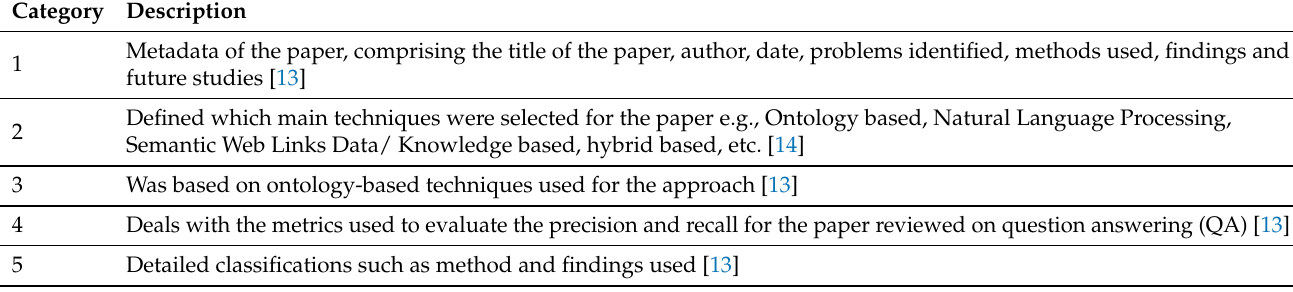
Table 1. Five categories created to classify the papers